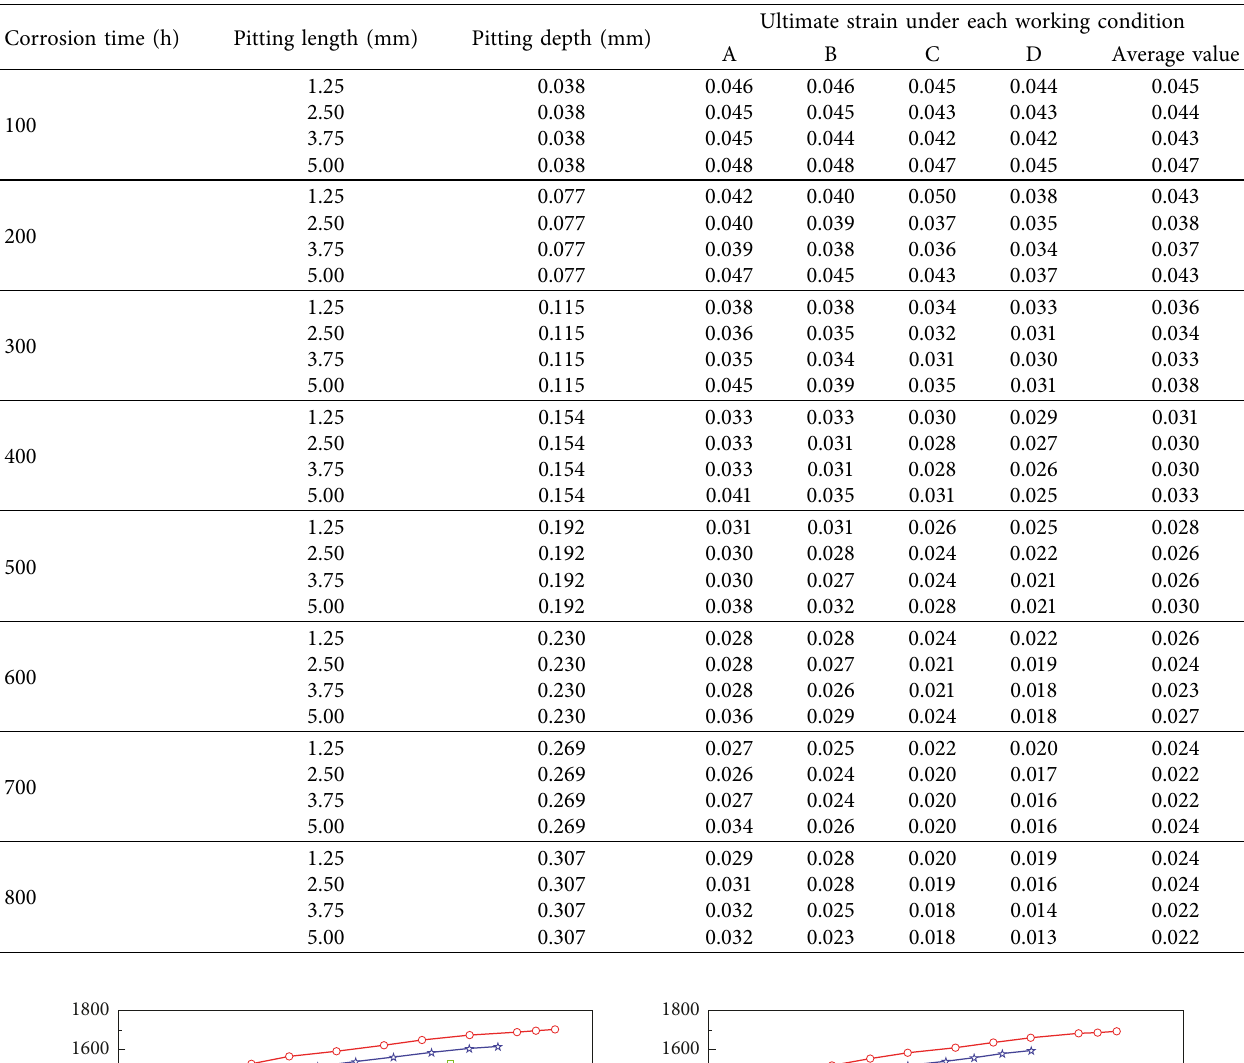
Table 2: Ultimate strain of steel wire under pitting corrosion at different